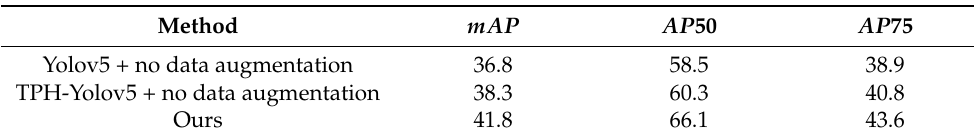
Table 2. The comparison of the performance in VisDrone2019 validation set about using and not using data augmentation.